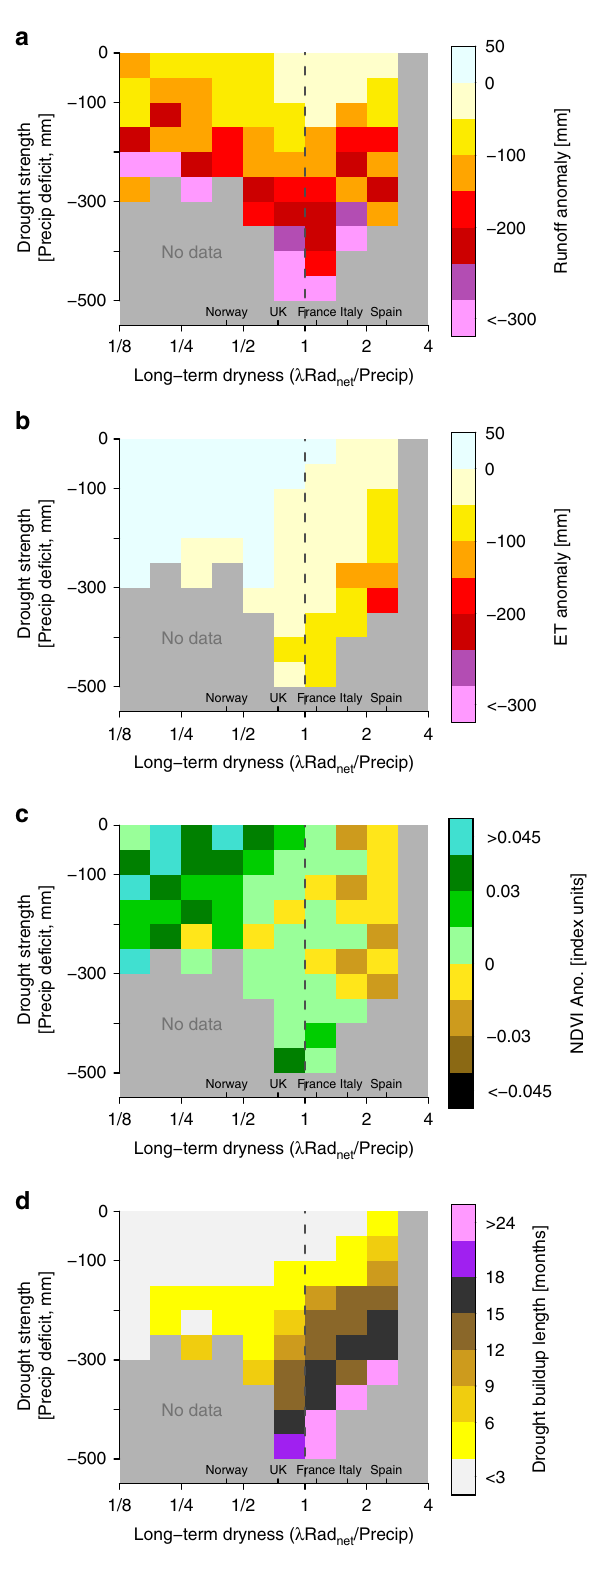
Fig. 3 Contrasting drought response of runoff, ET, and vegetation. Accumulated anomalies of a runoff, b ET, c Normalized Difference Vegetation Index (NDVI) during drought-buildup, and d length of the drought-buildup period, for different drought strengths (in terms of accumulated precipitation de fi cit, y -axis) and climate regimes (in terms of long-term dryness index, x -axis). Values shown in each box are means across all droughts characterized by the respective precipitation de fi cit and occurring in catchments with respective long-term